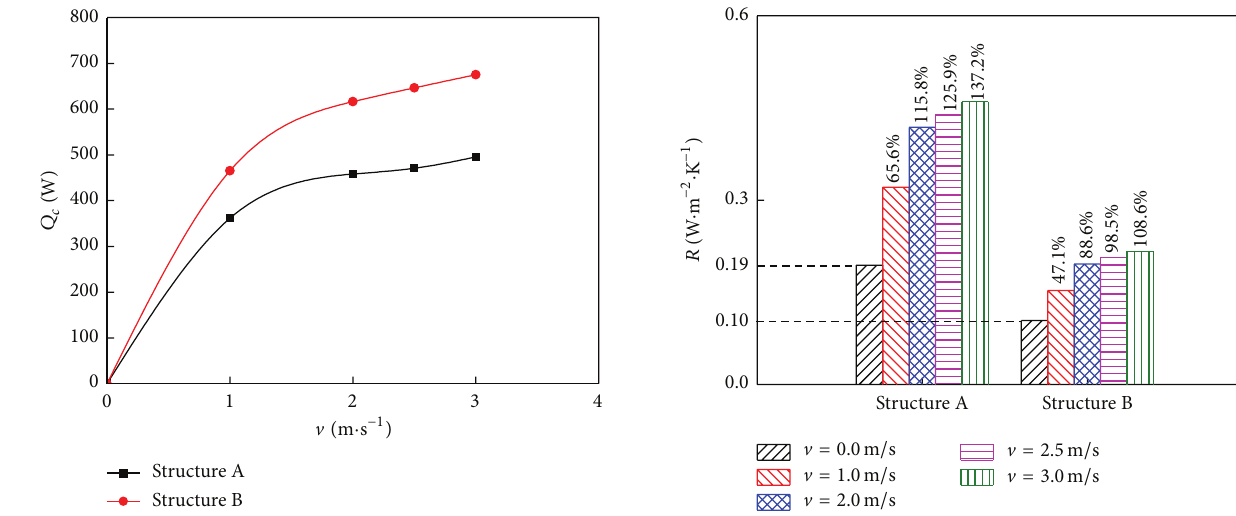
Figure 8: Contrast picture of quantity of heat with ventilation. Figure 9: Contrast picture of equivalent thermal